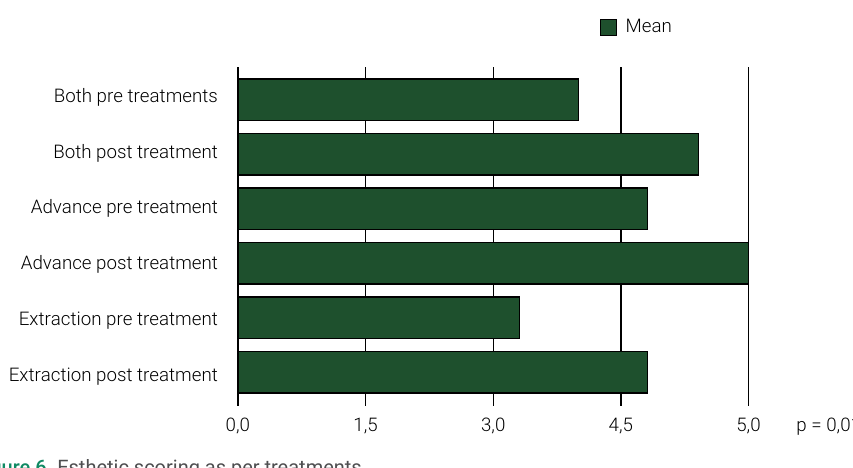
Figure 6. Esthetic scoring as per